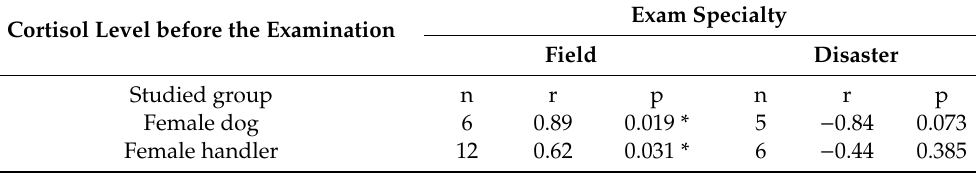
Table 7. Pearson’s r correlation coe ffi cients for the cortisol level before the exam in the groups: dog = female, handler = woman depending on the type of